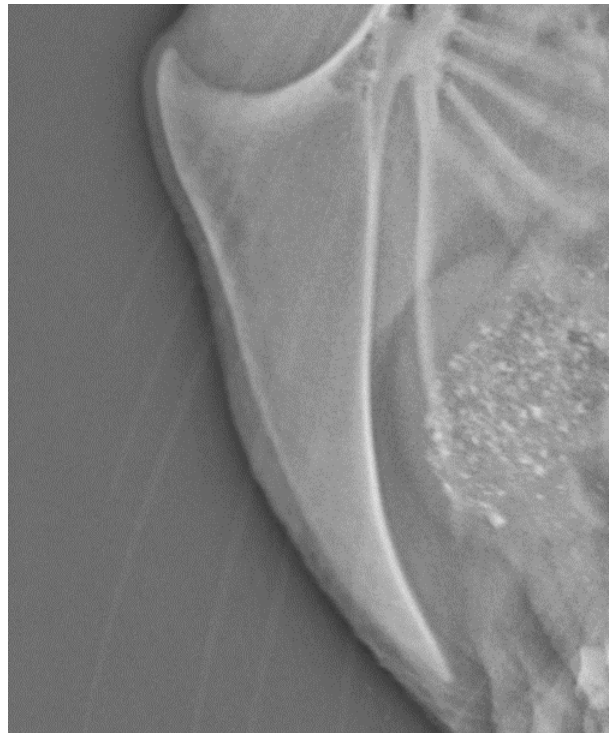
Figure 1. Normal, unfractured keel bone, 63 weeks of age .